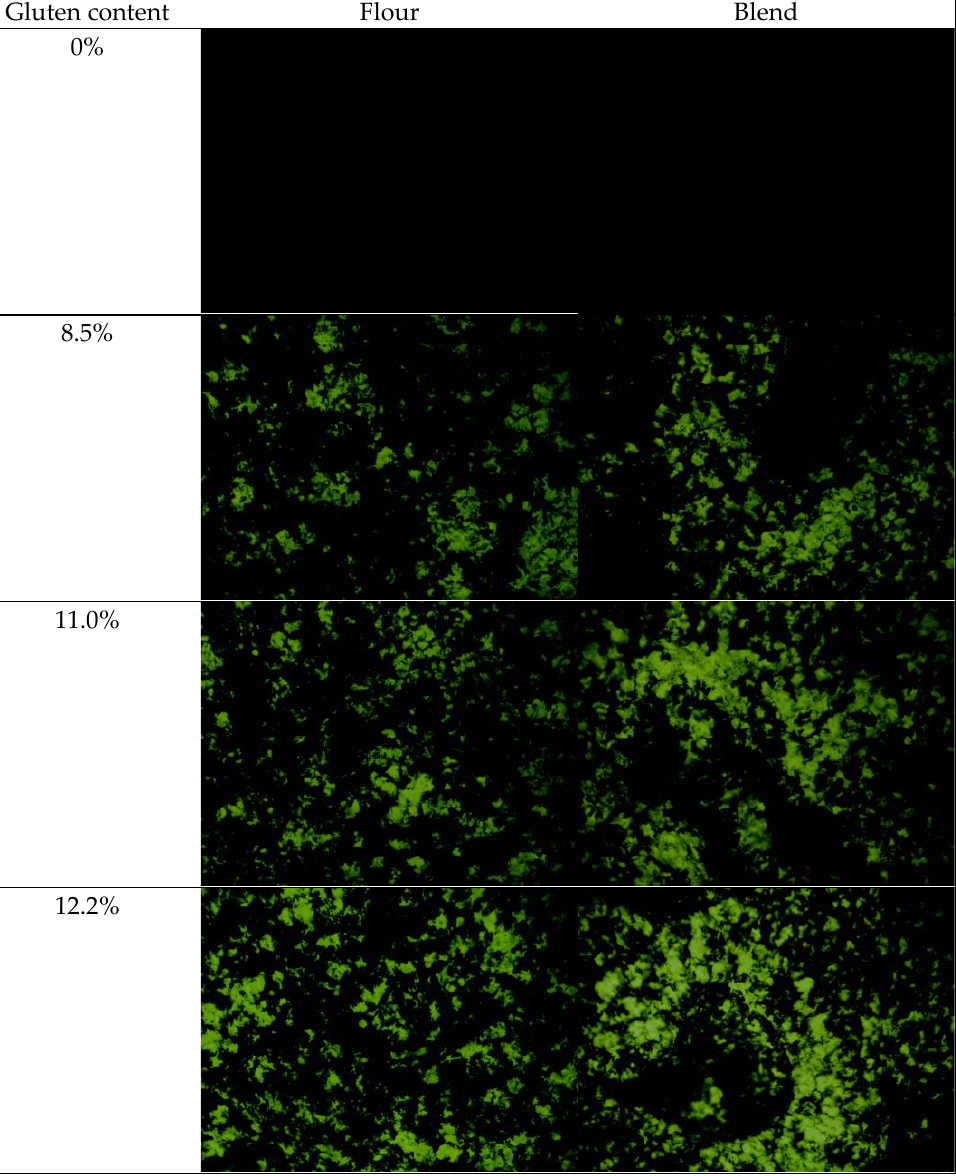
Figure 1. Light microscopy images (at a magnification of 20×) of the film-forming matrices of pure WS, wheat flours, and WS – gluten blends with different protein contents (8.5%, 11.0%, and 12.2%).